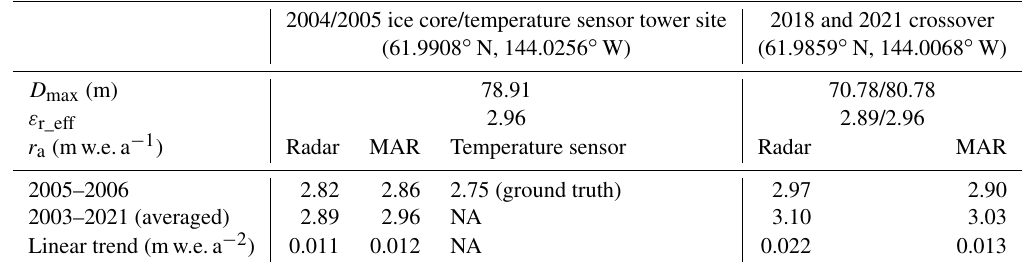
Table 3. Maximum layer depth observed D max , effective snow relative permittivity ε r_eff , and accumulation rates r a estimated at the two study